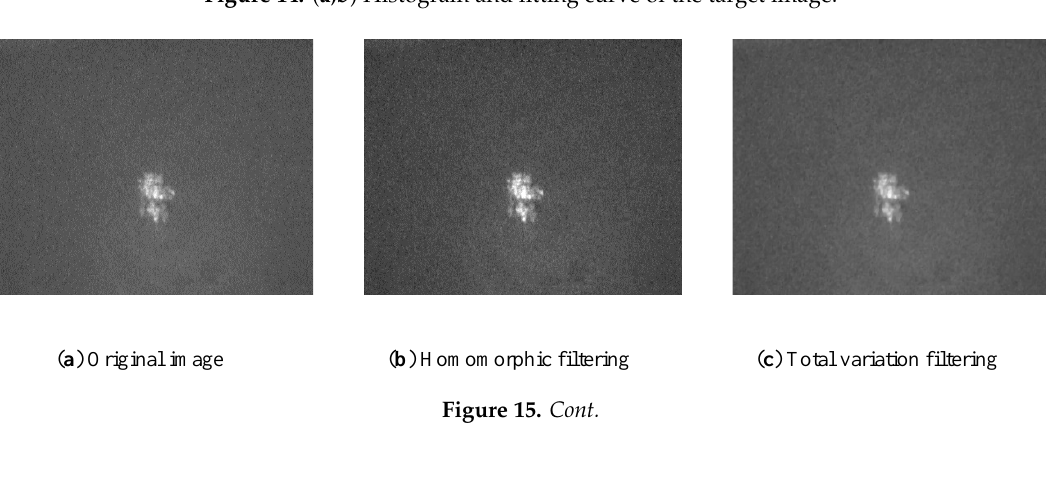
Figure 14. ( a , b ) Histogram and fitting curve of the target image.